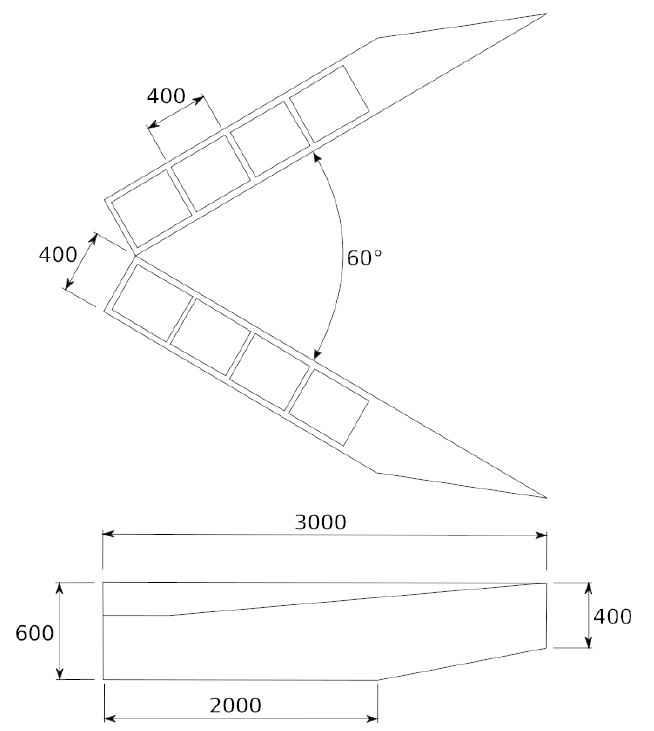
Figure 3. Plan view, above, and lateral view, below, of the model with dimensions shown in mm, at model scale. The wedge angle can be varied between 0 ◦ , closed, and 170 ◦